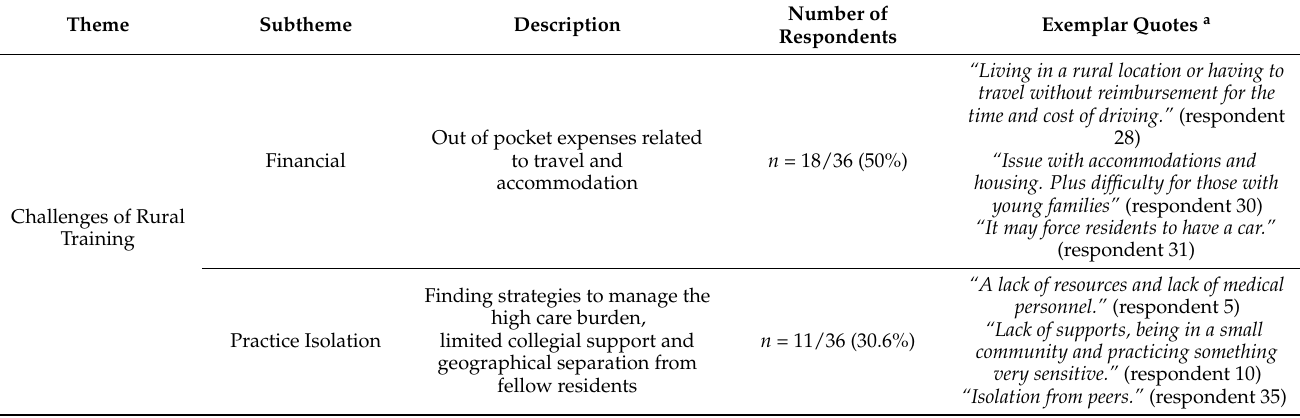
Table 2. Resident perceived rural challenges and opportunity for